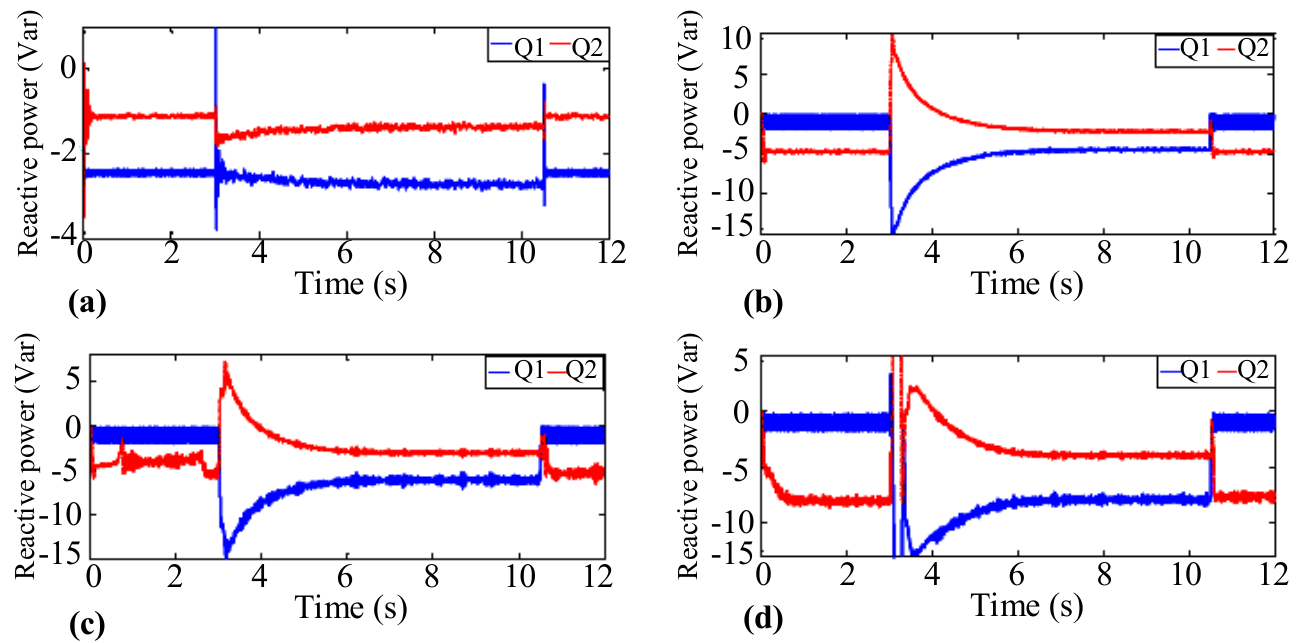
Figure 14. Reactive power changes in the first scenario using ( a ) the first strategy, ( b ) the second strategy, ( c ) the third strategy, and ( d ) the fourth strategy.